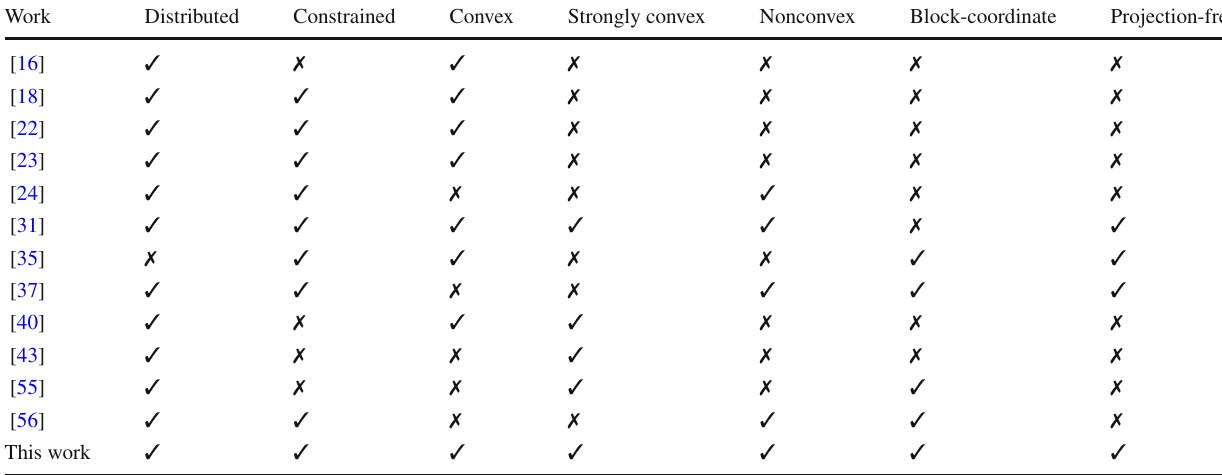
Table 2 The comparison of different algorithms Work Distributed